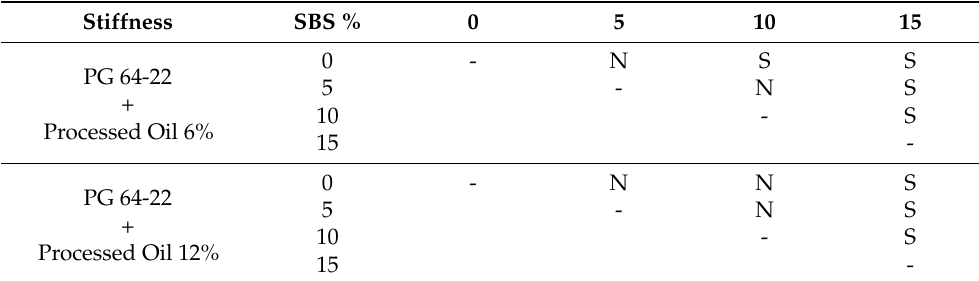
Table 11. Statistical analysis results of stiffness for RTFO + PAV aged PG 64 ‐ 22 with processed oil as a function of SBS content at − 12 °C ( α = 0.05).